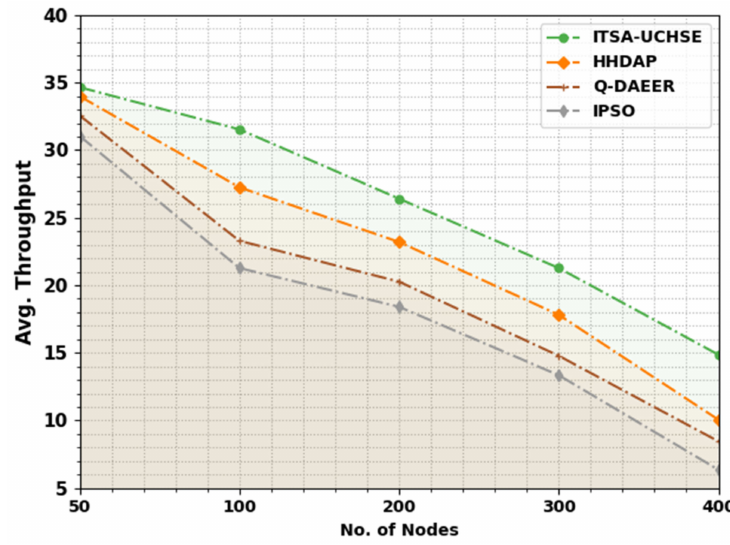
Figure 6. ATHRO analysis of ITSA-UCHSE system under distinct nodes.